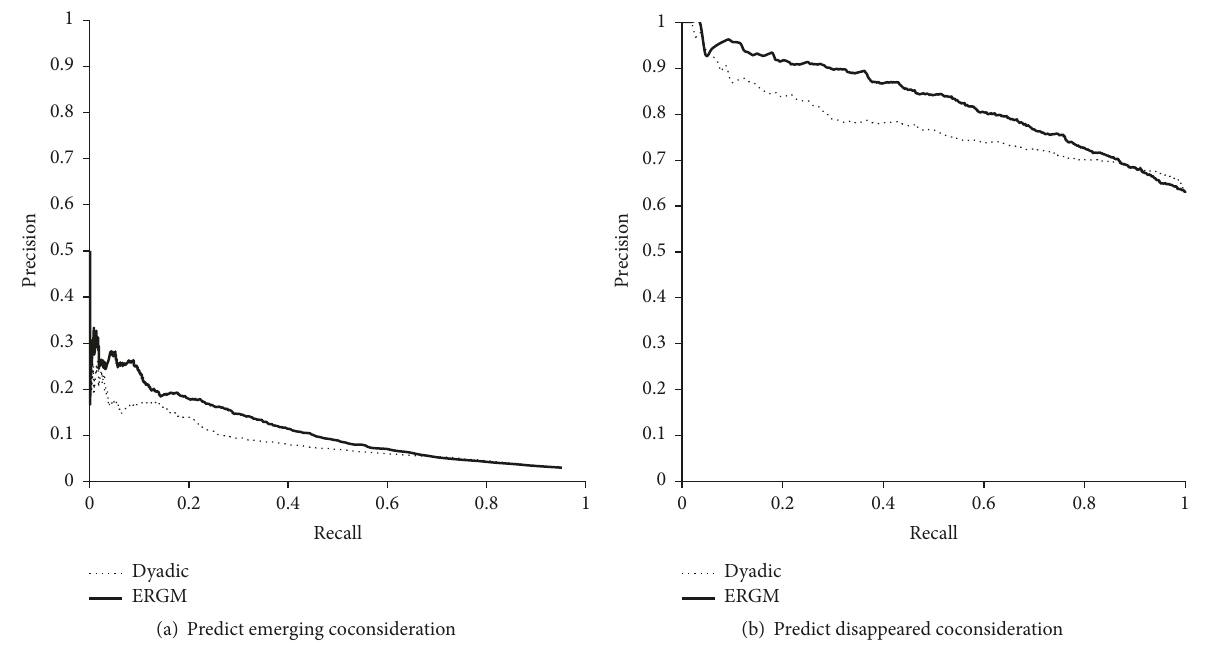
Figure 7: Prediction PR curves of dyadic model and ERGM in two prediction